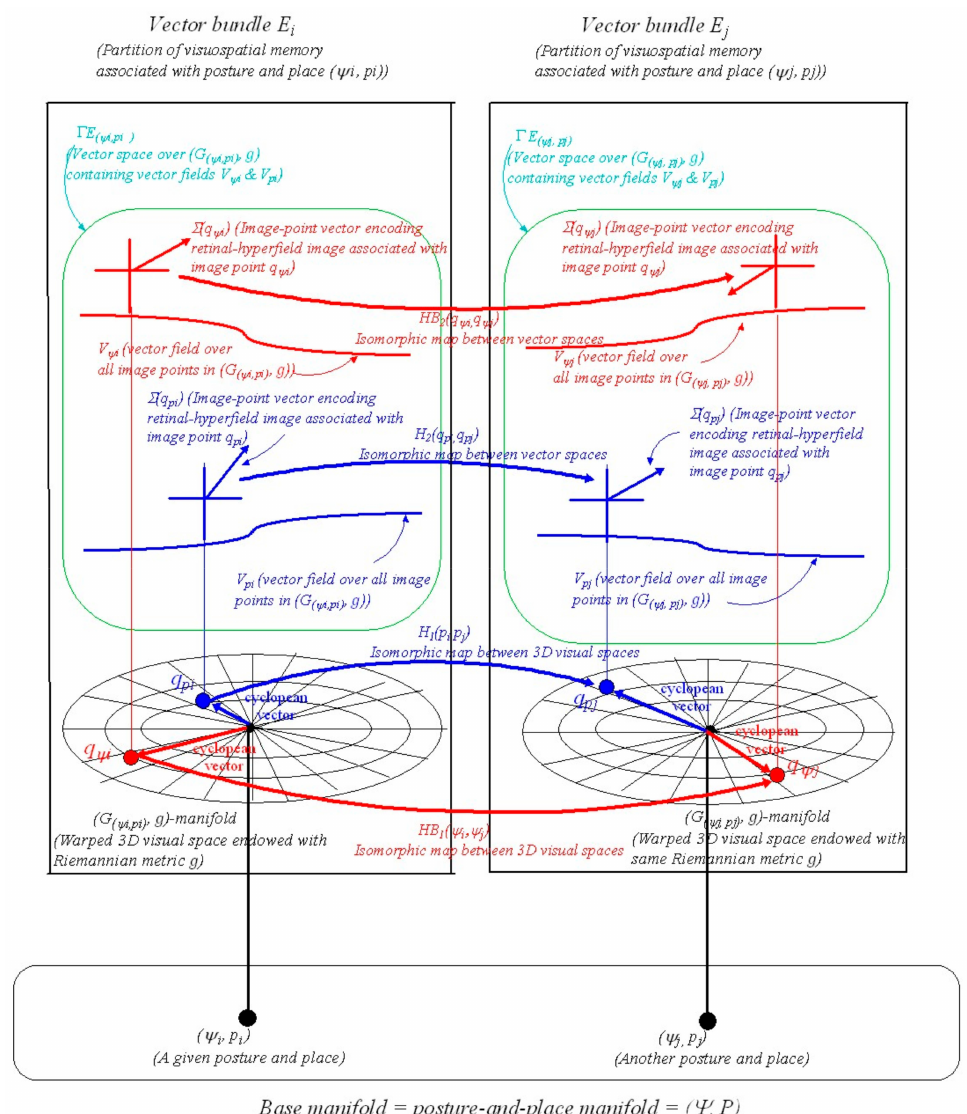
Figure 2. A schematic diagram of visuospatial memory illustrating the geometric fibre-bundle structure of place-and-posture-encoded visual images of objects in the environment and of the body in that environment as seen from each posture and place ( ψ i , p i ) . Posture is coloured red and place is coloured blue. At each point ( ψ i , p i ) there exists a fibre containing a vector bundle E i corresponding to a partition of visuospatial memory. Only two such vector bundles, E i and E j , are illustrated. (cid:16) (cid:17) G ( ψ , g represents the 3D perceived visual space encoded within each vector bundle. H 1 i , p i ) (cid:16) (cid:17) (cid:16) (cid:17) (cid:16) (cid:17) H 2 q p q ψ ψ i , ψ j , q p , H B 1 , and H B 2 , q ψ represent adaptively-tuned and wired-in maps (vector i j i j bundle morphisms) between each and every partition of visuospatial memory. When a change occurs in the place p i of the head and/or the posture ψ i of the body, these vector bundle morphisms map the corresponding changes in the retinal-hyperfield image points q (cyclopean vector) and image-point vectors Σ ( q ) for fixed points in the environment and/or on the surface of the body. Further description follows in the